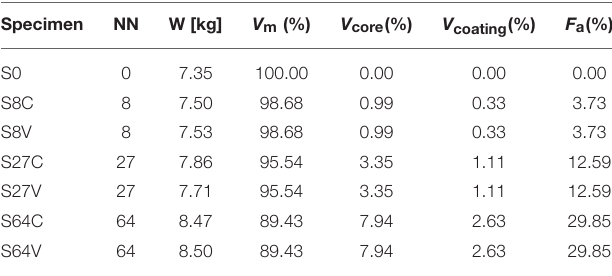
TABLE 1 | Characteristics of the specimens.